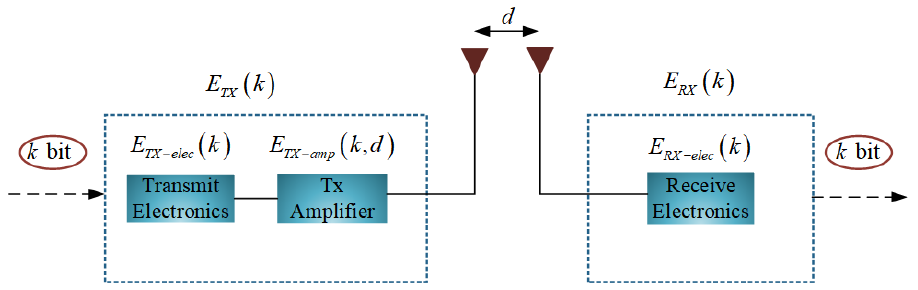
Figure 3. First order radio